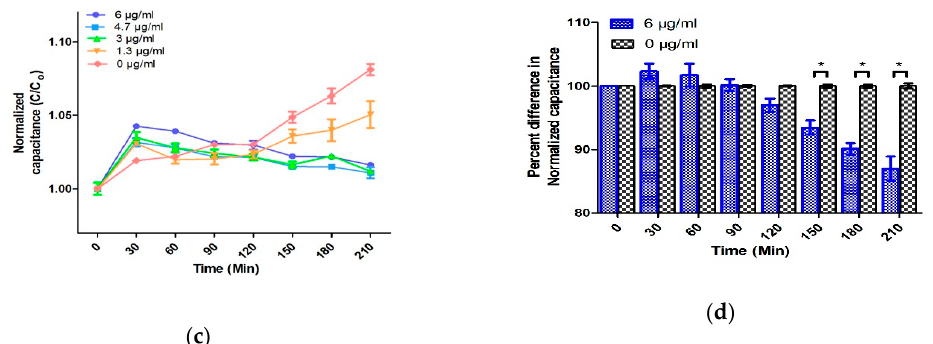
Figure 3. AST evaluation of 10 6 CFU / mL E. coli in TSB media: ( a ) The change in the OD 600 nm with time, ( b ) the percentage change in the OD between control and antibiotic-treated samples, ( c ) the change in normalized capacitance with time; and ( d ) the percentage change in the normalized capacitance between control and antibiotic-treated samples. Error bars represent the standard deviation from the mean values of three experiments (significance indicators: * p < 0.05, ** p < 0.01, and *** p < 0.001).